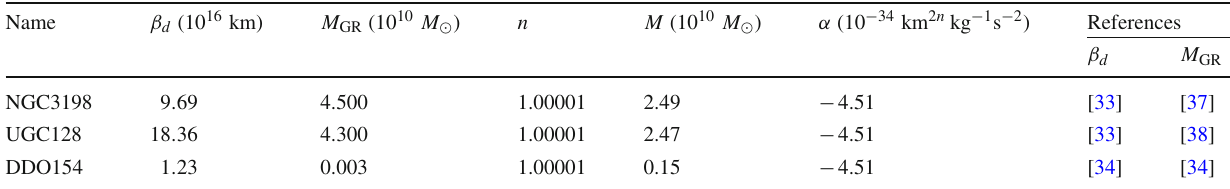
Table 4 Best fit of galactic mass for NGC 3198, UGC 128 and DDO